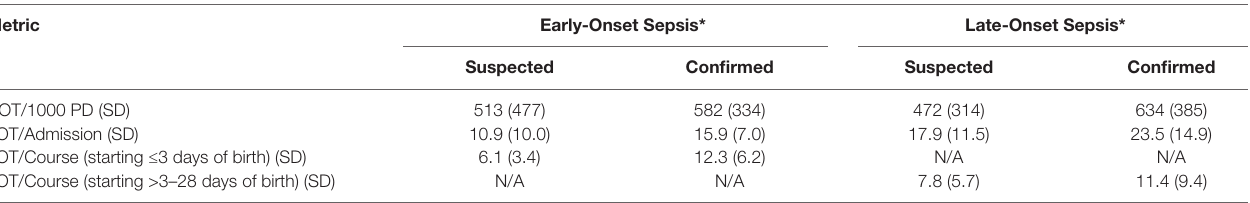
TABLE 3 | Measurements of total antibiotic exposure per